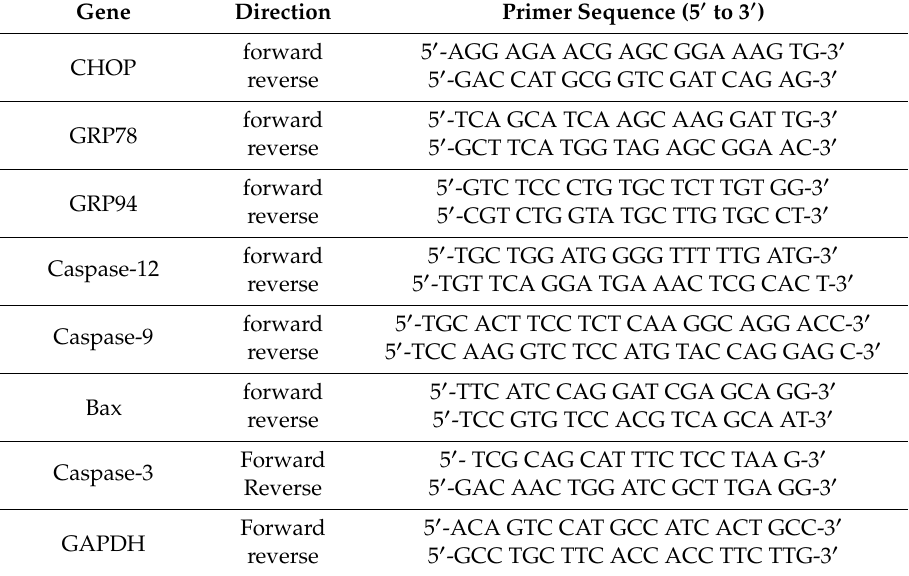
Table 1. Primer sequences used for quantitative real-time PCR.